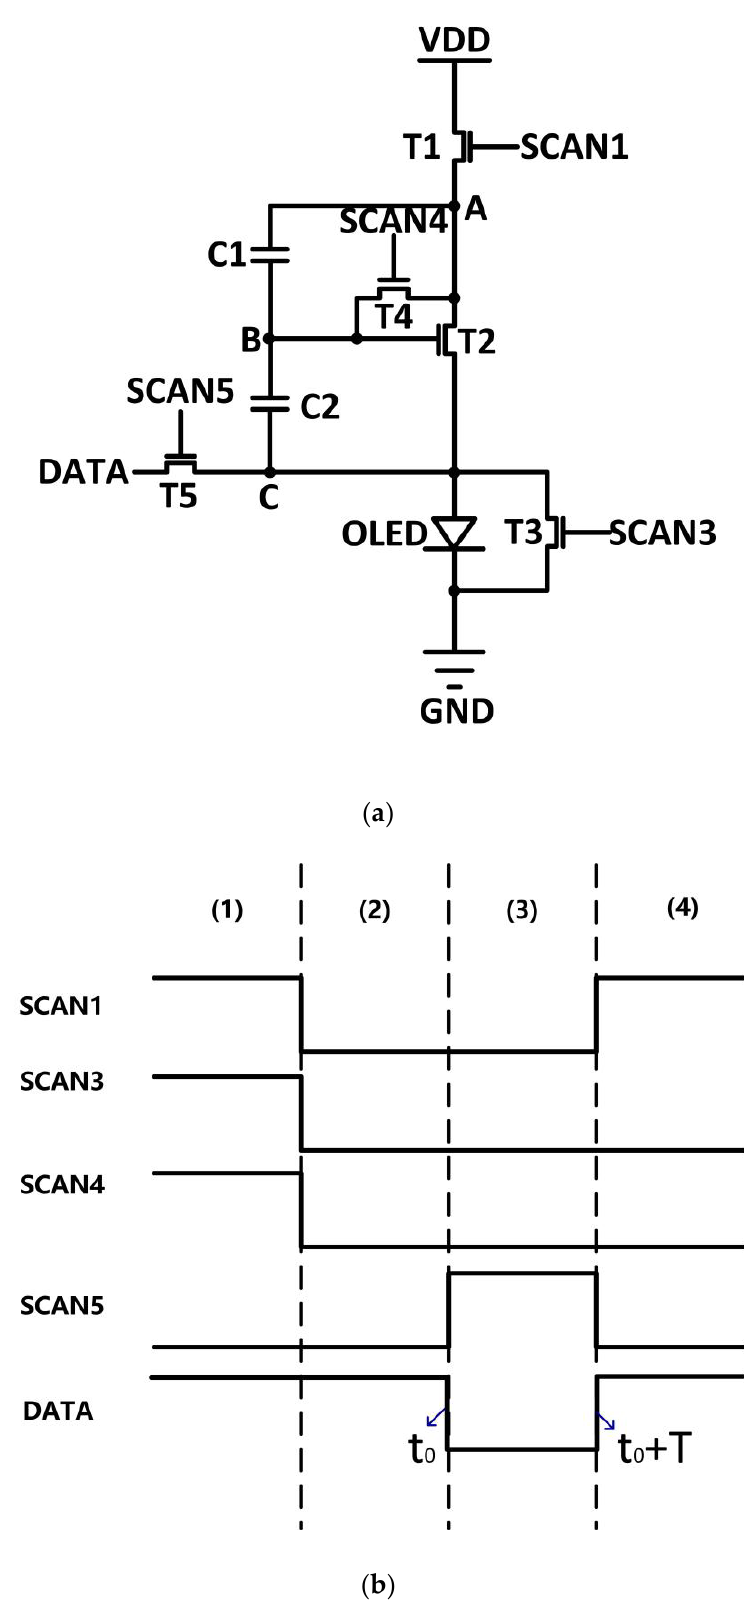
Figure 2. ( a ) Schematic of the proposed pixel circuit and ( b ) timing diagram: (1) initialization stage, ( 2) threshold voltage extraction stage, (3) data input stage, and (4) emission stage.